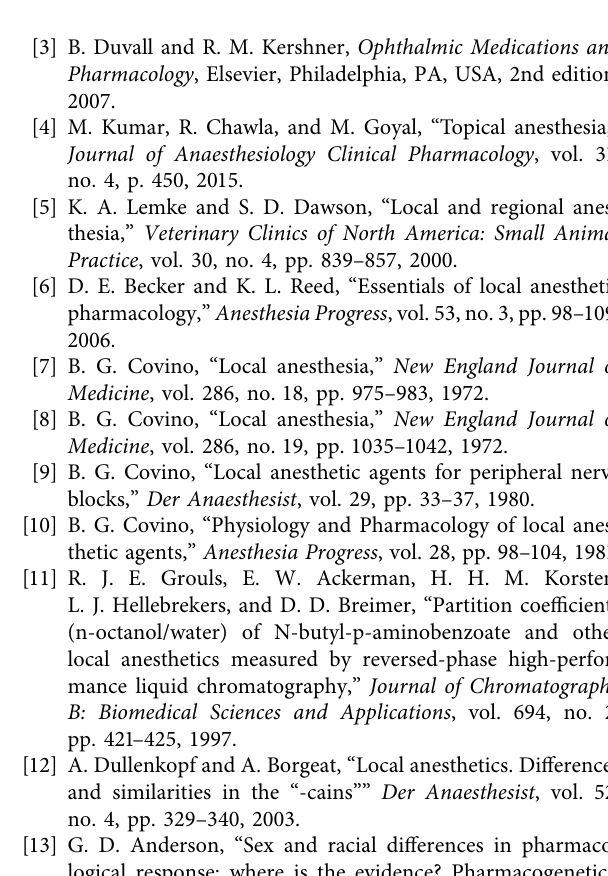
Figure 2: Time course curve showing the effect of sex on the onset and duration of actions of (a) proparacaine and (b) tetracaine. Values plotted are mean corneal touch threshold ± standard error of mean ( n � 120). Repeated measures ANOVA followed by post hoc Tukey